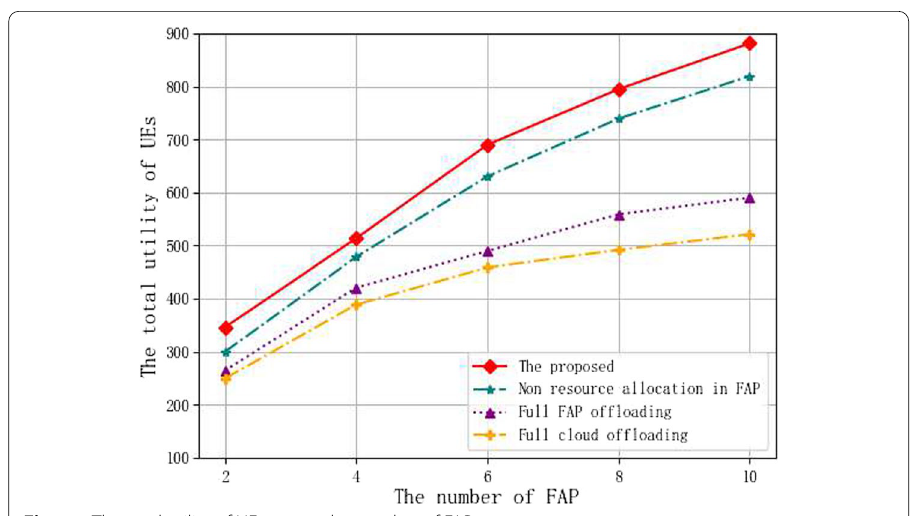
Fig. 11 The total utility of UEs versus the number of